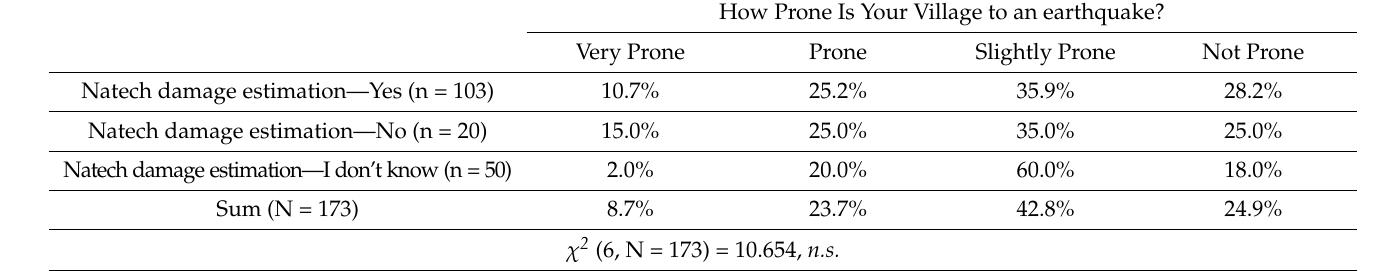
Table 5. Cont. How Prone Is Your Village to an earthquake?